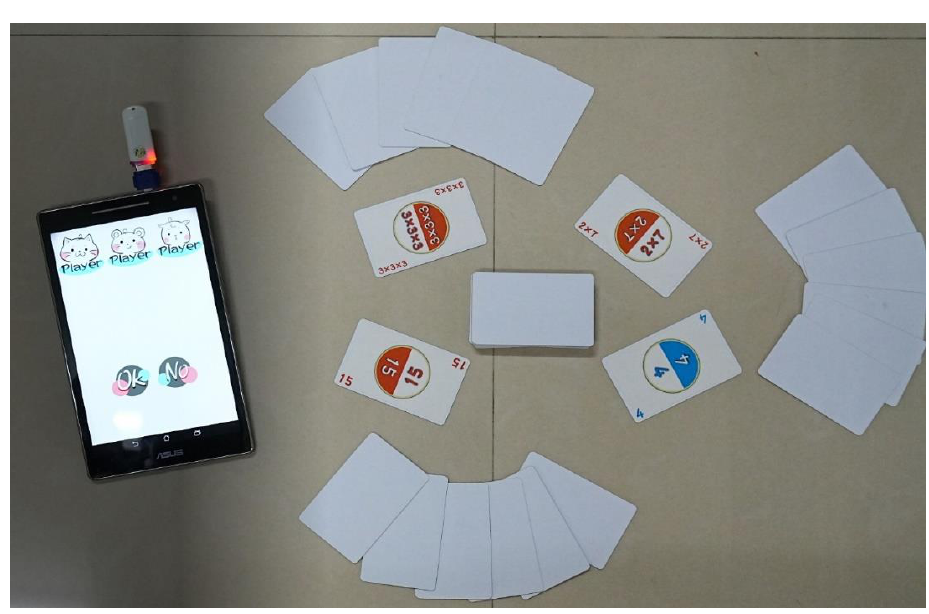
Figure 2. Faces of 40 RFID cards.